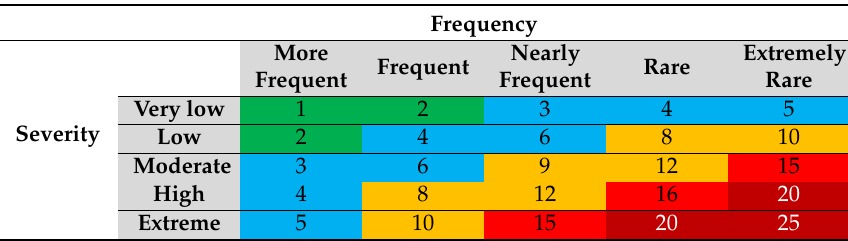
Table 3. Risk identification matrix or critical